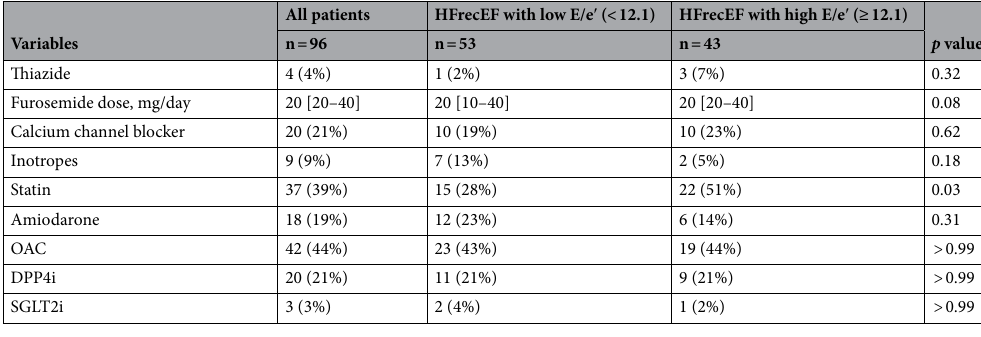
Table 1. Patients’ characteristics at discharge according to HFrecEF with low or high E/e ′ ratio at the 1-year follow-up. ACEi angiotensin converting enzyme inhibitor, ARB angiotensin receptor blocker, OAC oral anti- coagulants, BMI body mass index, BNP brain natriuretic peptide, BP blood pressure, bpm beats per minute, CABG coronary artery bypass grafting, CRP C-reactive protein, CRT cardiac resynchronization therapy, DPP4i dipeptidyl peptidase-4 inhibitor, E/e ′ peak velocity of the early wave (E) to early diastole (e ′ ) ratio, eGFR estimated glomerular filtration rate, HDL high density lipoprotein, HFrecEF heart failure with recovered ejection fraction, HT hypertension, ICD implantable cardioverter defibrillator, IDDM insulin dependent diabetes mellitus, IVC inferior vena cava, LAD left atrial dimension, LAVI left atrial volume index , LDL low density lipoprotein, LVEF left ventricular ejection fraction, LVDd left ventricular end-diastolic diameter, LVDs left ventricular end-systolic diameter, LVMI left ventricular mass index, OAC oral anticoagulants, PM pacemaker, RVSP right ventricular systolic pressure, SGLT2i sodium-glucose cotransporter 2 inhibitor, T-Chol total cholesterol, TR Vmax maximal tricuspid regurgitation velocity, WBC white blood